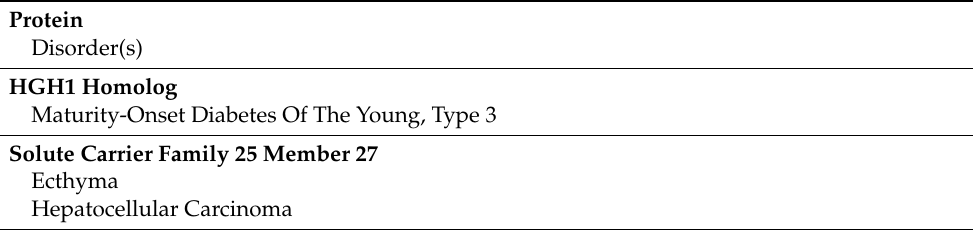
Table A1. Disorders associated with the identified proteins, in the order of ascending number of associated diseases. (Information retrieved from the resources detailed in the Materials and